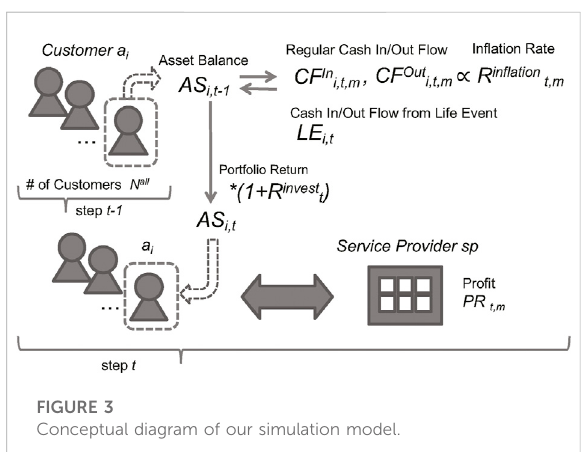
FIGURE 3 Conceptual diagram of our simulation